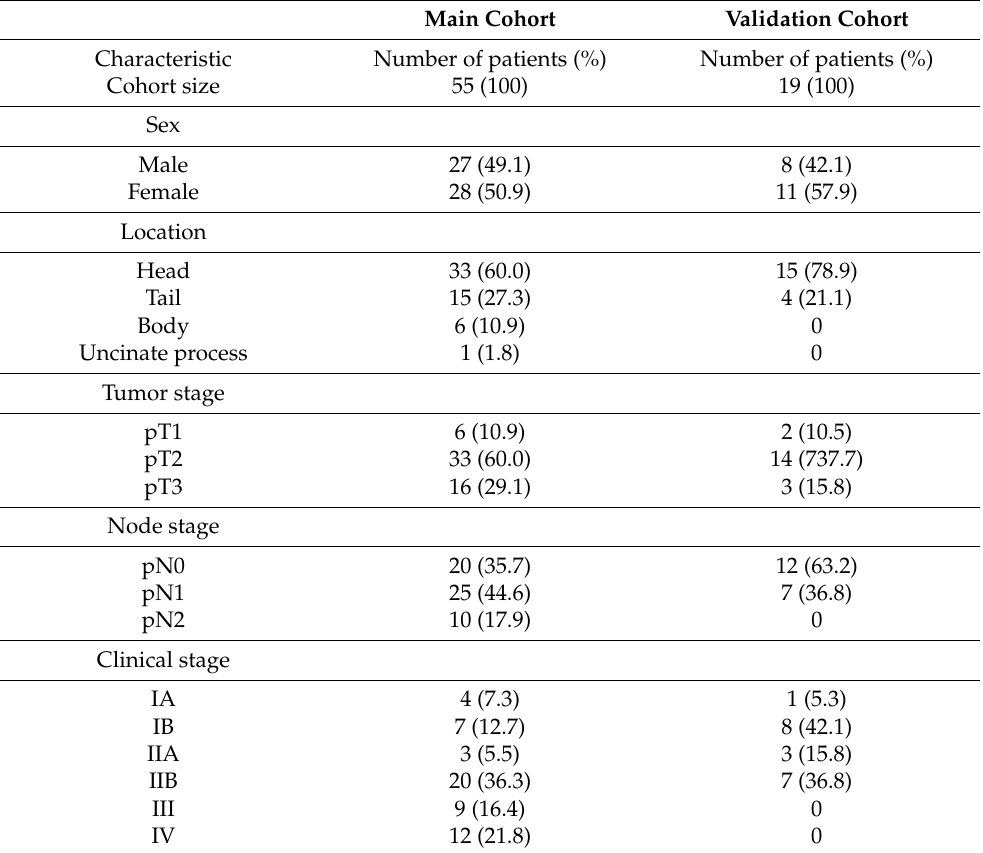
Table 1. Characteristics of patients with pancreatic